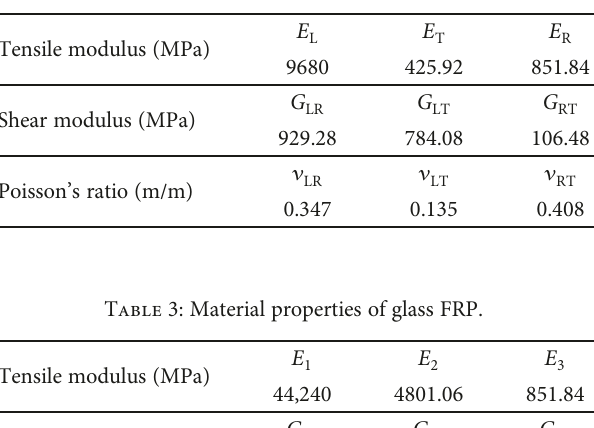
Figure 4: Con fi gurations of (a) wood, (b) FRP, and (c) an FRP wrap. Table 2: Mechanical properties of red pine ( Pinus resinosa ).